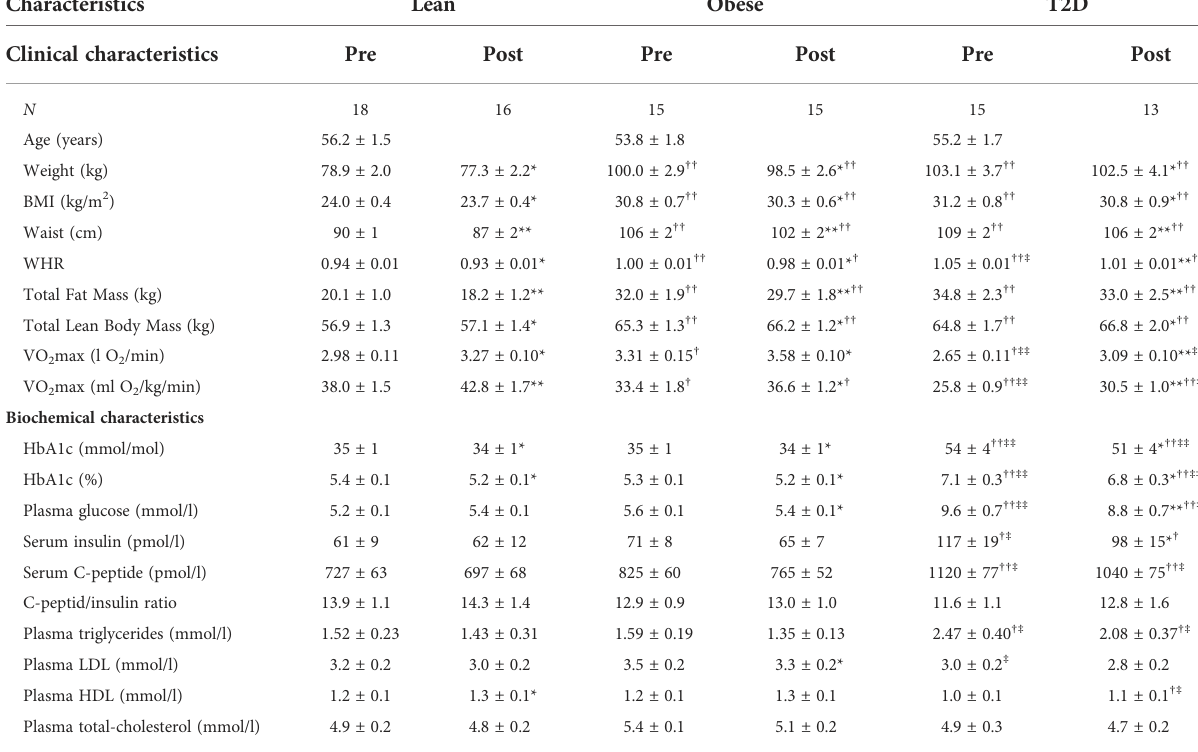
TABLE 1 Clinical and biochemical characteristics, pre- and